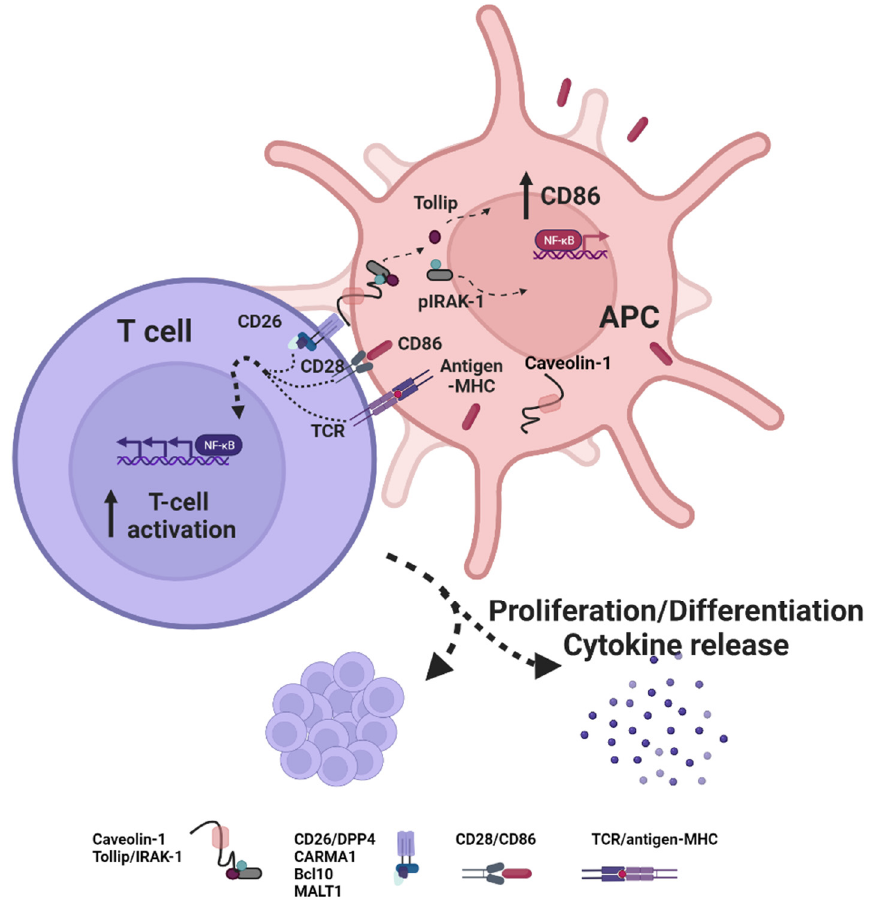
Figure 4. Interaction of CD26 with caveolin-1. Caveolin-1 on the surface of antigen-presenting cells (APC) binds to CD26 on the T-cell surface. This interaction induces an increase of the expression of the costimulatory ligand CD86 on APC thus enhancing T-cell co-stimulation by binding to CD28. In addition, caveolin-1-mediated CD26 ligation results in the recruitment of a complex composed of CD26, CARMA1, Bcl10, and MALT1 to lipid rafts and subsequent NF- κ B activation in a TCR/CD3- dependent manner. CD26-mediated co-stimulation enhances the T-cell proliferation and effector function with respect to cytotoxic properties and cytokine release.